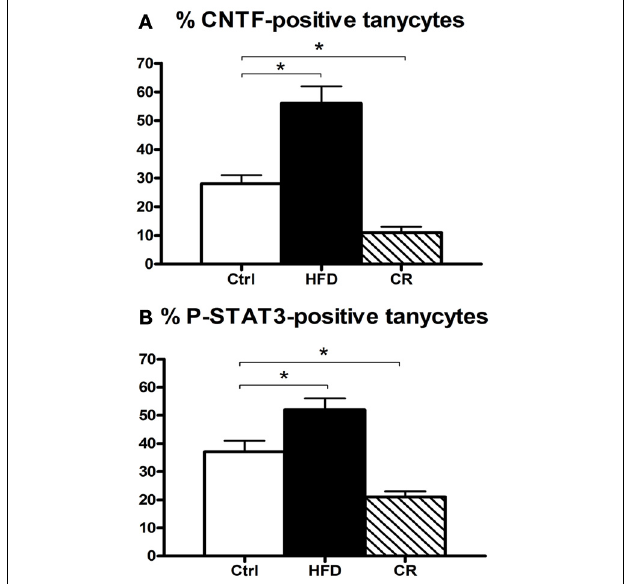
FIGURE 5 | Percentage of CNTF-producing (A) and CNTF-responsive (B) tuberal and mammillary tanycytes in HFD, control (Ctrl) and CR mice. Morphometric evaluation performed by confocal microscopy in double-stained sections where tanycytes were labeled by GFAP and CNTF responsiveness was evaluated by P-STAT3 immunohistochemistry in CNTF-treated mice. Mean ± SEM. ∗ P < 0 .